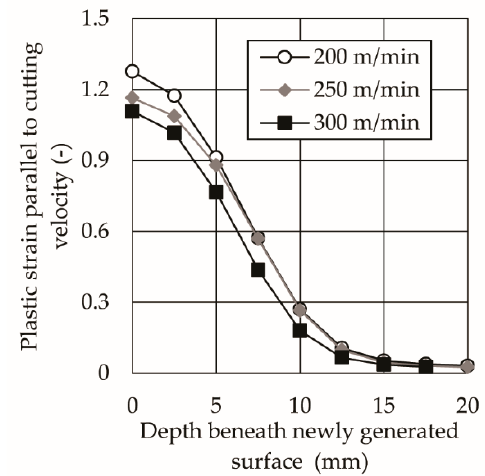
Figure 15. Effect of cutting speed on predicted plastic strain distribution beneath newly generated Figure 15. E ff ect of cutting speed on predicted plastic strain distribution beneath newly surface. generated